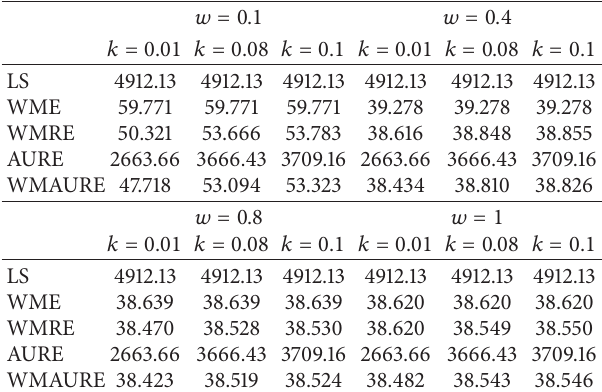
Table 2: Estimated MSE values of the WME, WMRE, AURE, and WMAURE. 𝑤 =